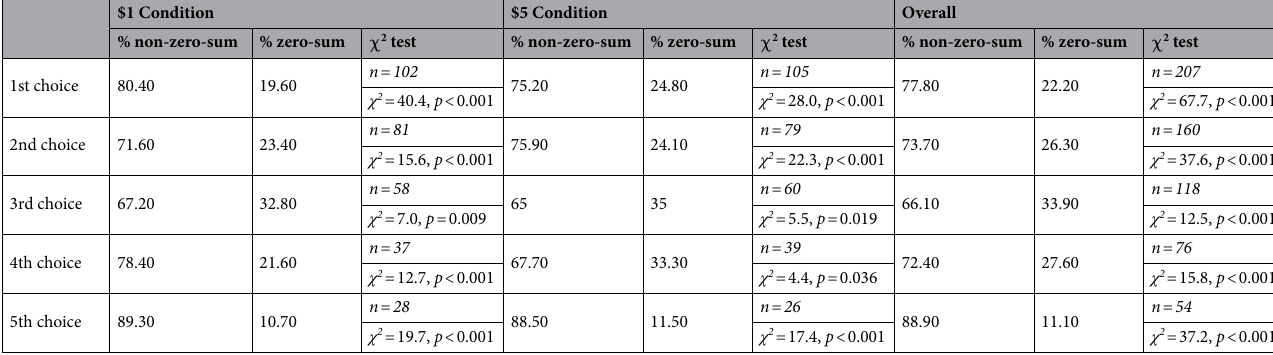
Table 1. The likelihood of choosing the zero-sum option across the five different stages in the $1 condition (left), $5 condition (middle) and both conditions combined (left) (Study